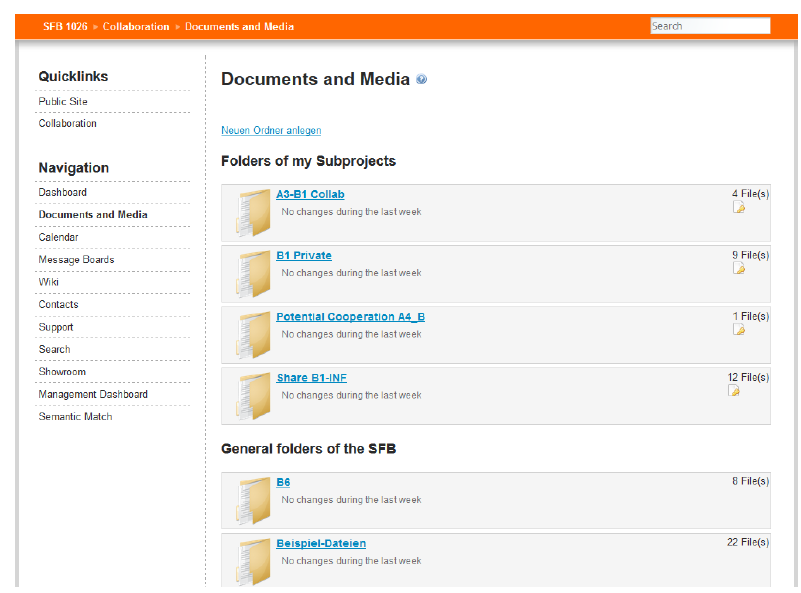
Figure 3. User interface of the “documents and media” section of the collaboration platform.